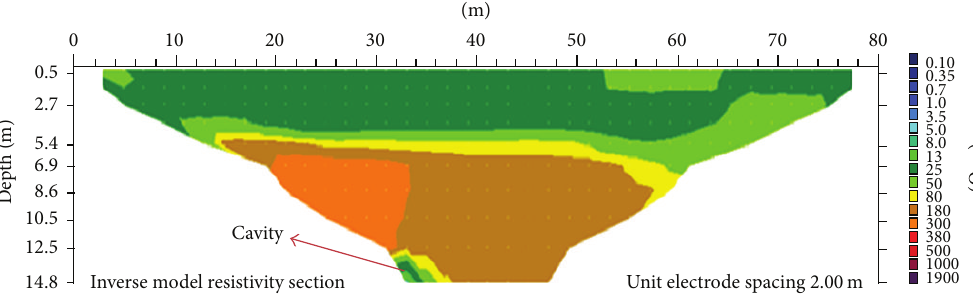
Figure 10: Investigation of 2D resistivity image of third line.